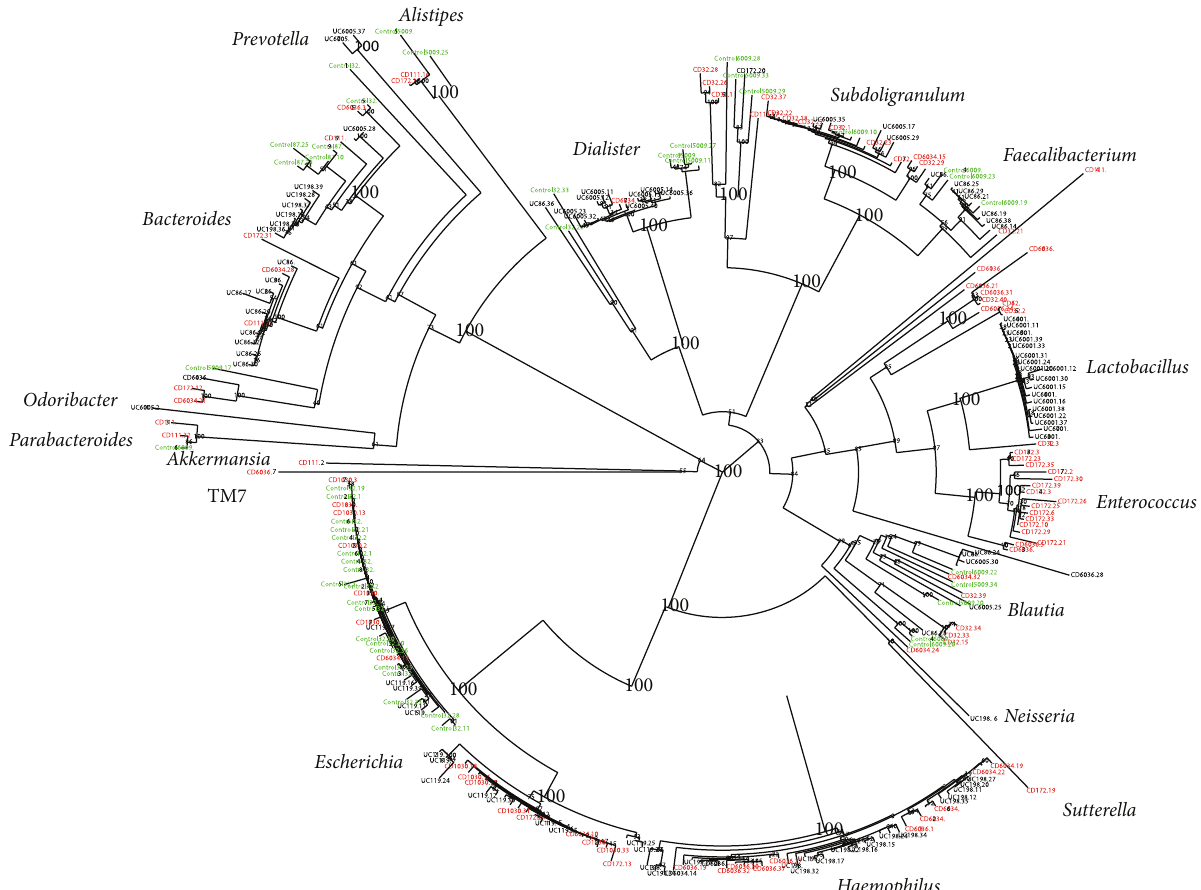
Figure 2: Neighbour joining phylogenetic tree for the nearly full-length sequences obtained in this work. The numbering at the nodes is the bootstrap support, with the 100% support values highlighted. For each sequence, the colour code indicates the patients diagnosis: green— control, red—CD, and